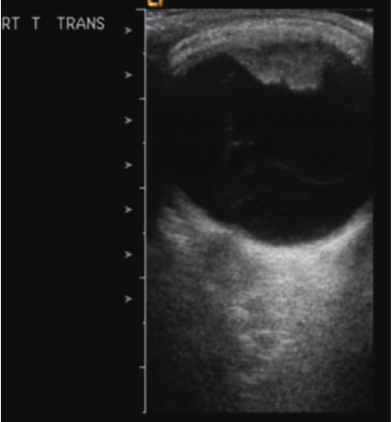
Figure 2: An irregular-surfaced ciliary body mass with heteroge- neous echogenicity as seen on B-scan ultrasound imaging. There was no satellite